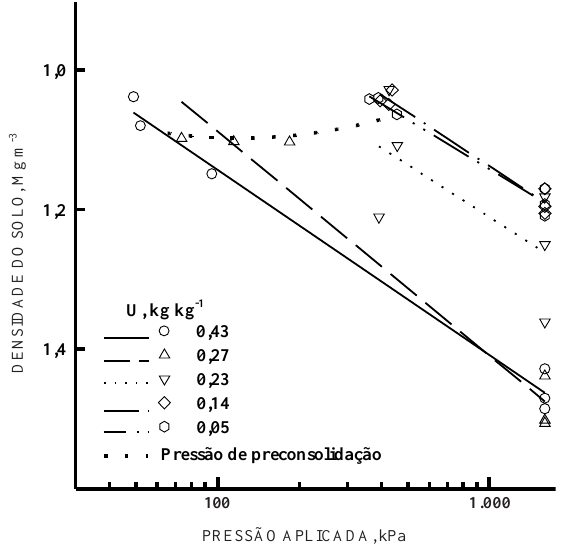
Figura 2. Retas de compressão virgem ajustadas para o Latossolo Vermelho-Escuro sob cultivo anual, na profundidade de 0-0,03 m, com diferentes umidades gravimétricas (U) (n =